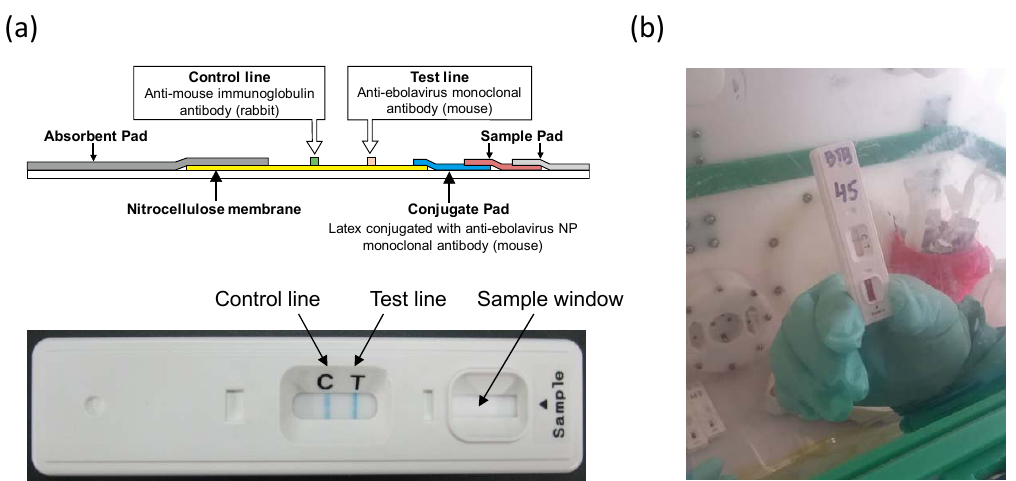
Figure 1. ( a ) Illustration of QuickNavi TM -Ebola. A sample added to the sample window of the device migrates via capillary action. The ebolavirus NP antigens present in the sample bind to the latex-conjugated mAb on the conjugate pad. Another mAb is immobilized on a nitrocellulose membrane at the Test line position and captures the complexes of NPs and mAbs conjugated with latex. Those complexes deposit a visible blue line. ( b ) QuickNavi TM -Ebola used at a field laboratory in North-Kivu